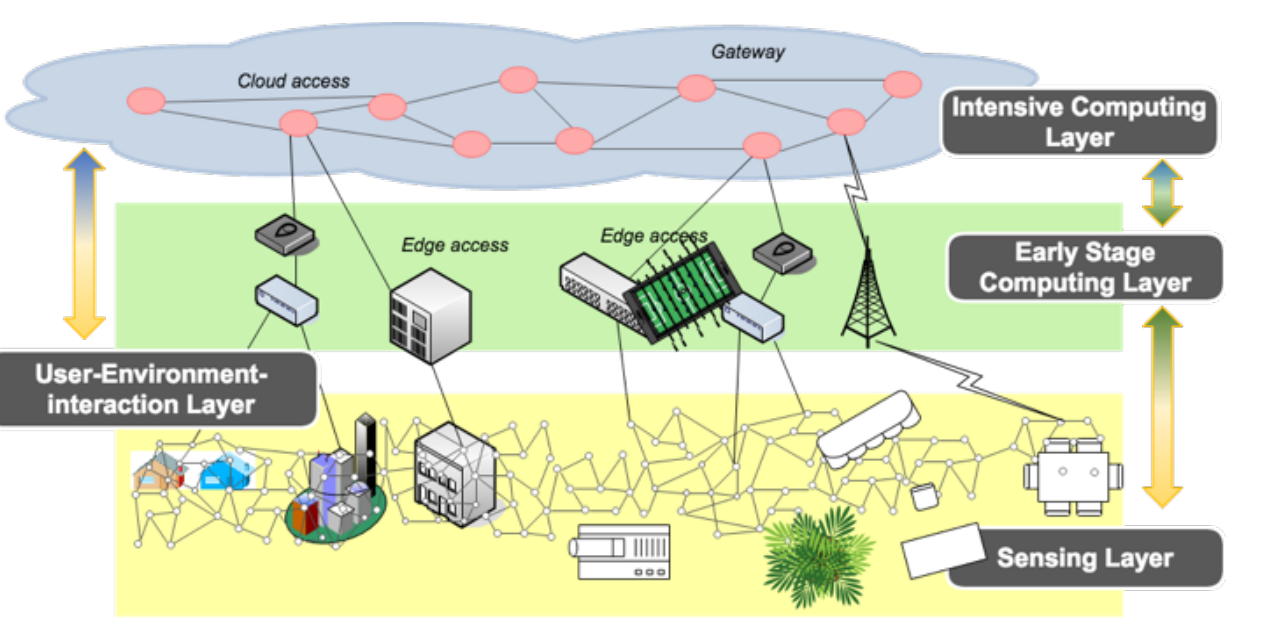
Figure 5. The proposed PyFF system